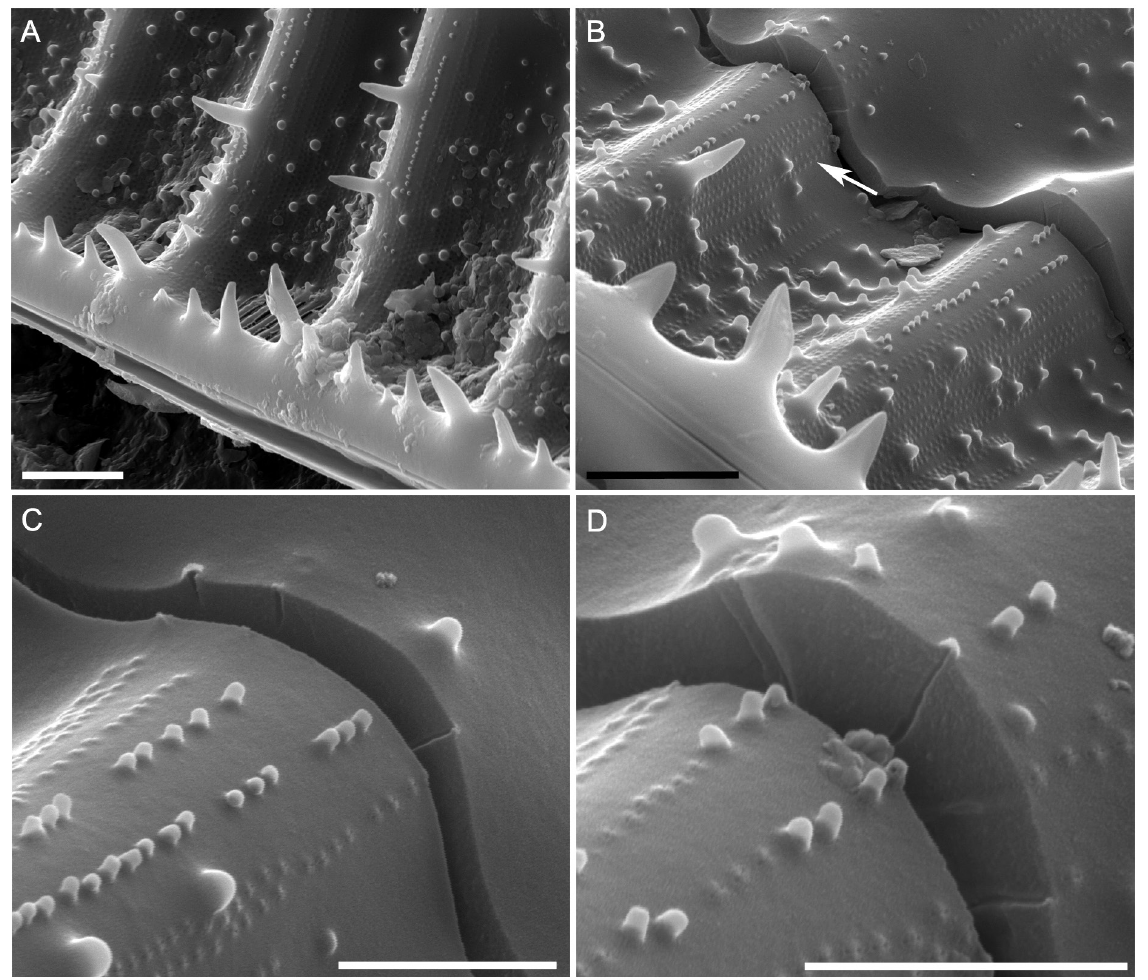
Fig. 4. Surirella ebalensis sp. nov., type material from sample CCA 2070, Lomami River, DR Congo, SEM. External view. Details of the various types of spines on the valve face and the keel. A–B . Detail of the valve surface with the biseriate striae (arrow) becoming sometimes uniseriate near the axial area. C–D . Section of the valve face showing the simple perforation of the silica wall at the areolae. Scale bars: A–B = 2 µm; C–D = 1